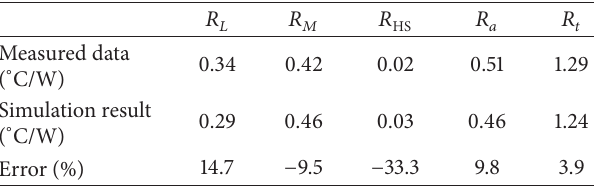
Table 4: Comparisons between experimental and numerical ther- mal resistances of A.C. 30 W.